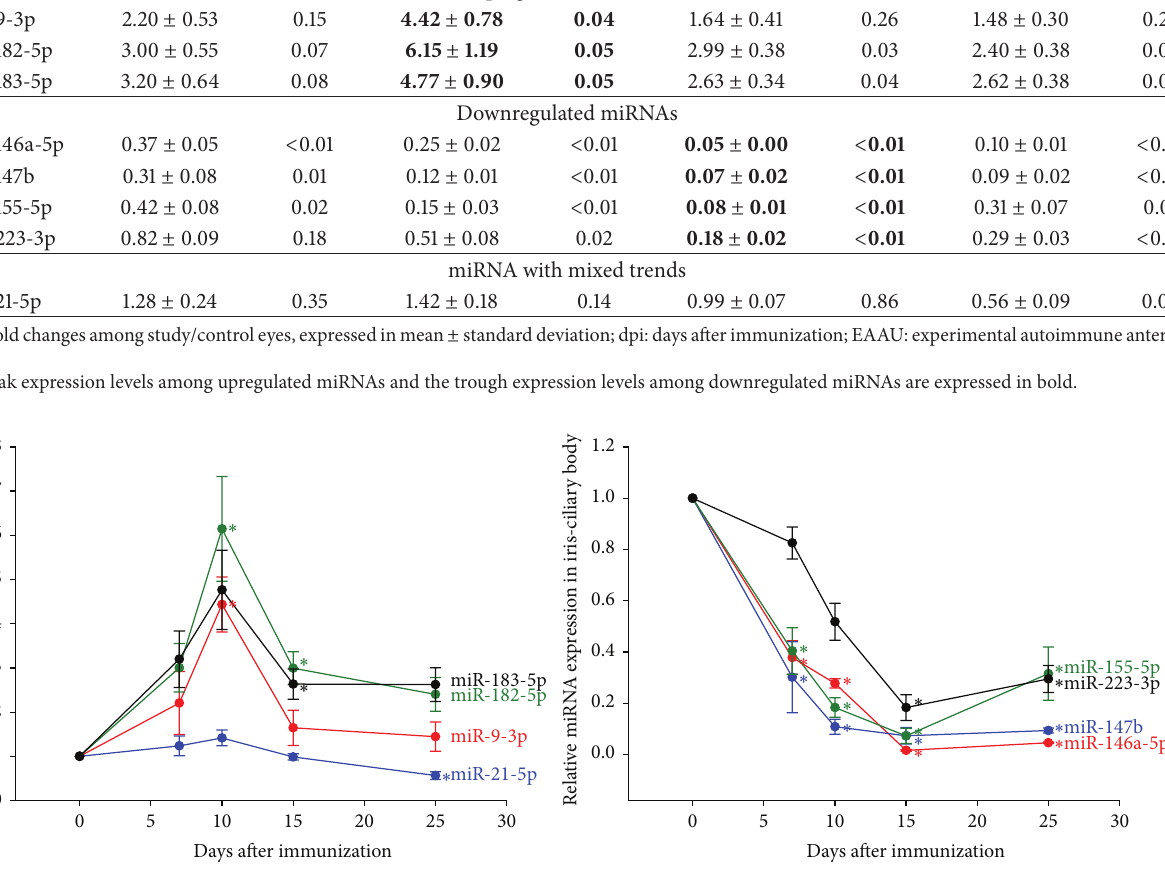
Figure 2: Relative expression levels of microRNAs in iris/ciliary bodies. ∗ Significant differential expression among study and control eyes ( 𝑃 < 0.05